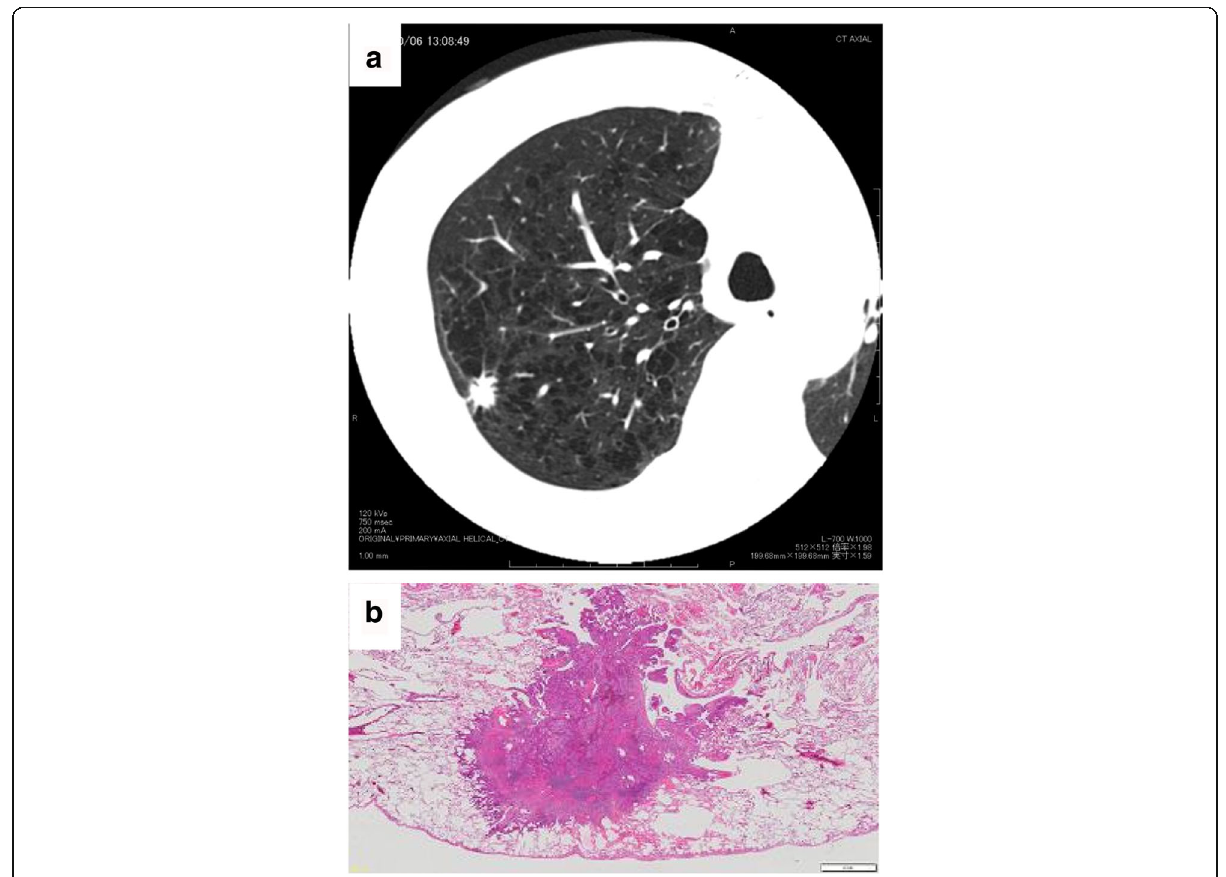
Fig. 1 a Chest thin-slice computed tomography (TSCT) showing a 1.1-cm solid nodule in the right upper lobe. b Pathologic features of the nodule, showing adenocarcinoma (macroscopic